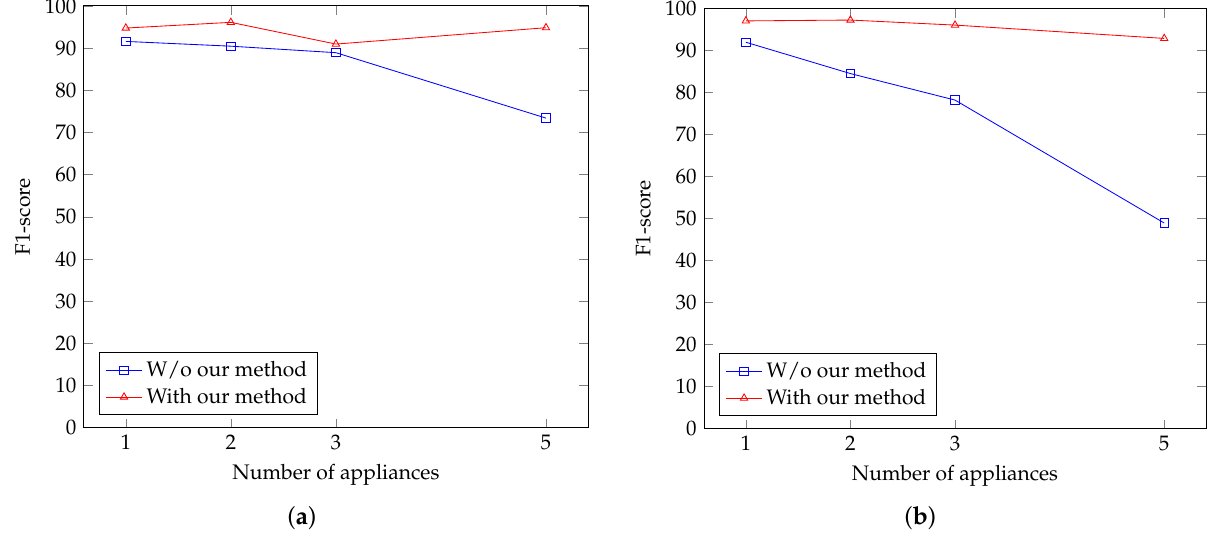
Figure 9. The F1-score corresponding to the number of appliances on Tracebase with (a) VDOCNN model and (b) Xception model, respectively.